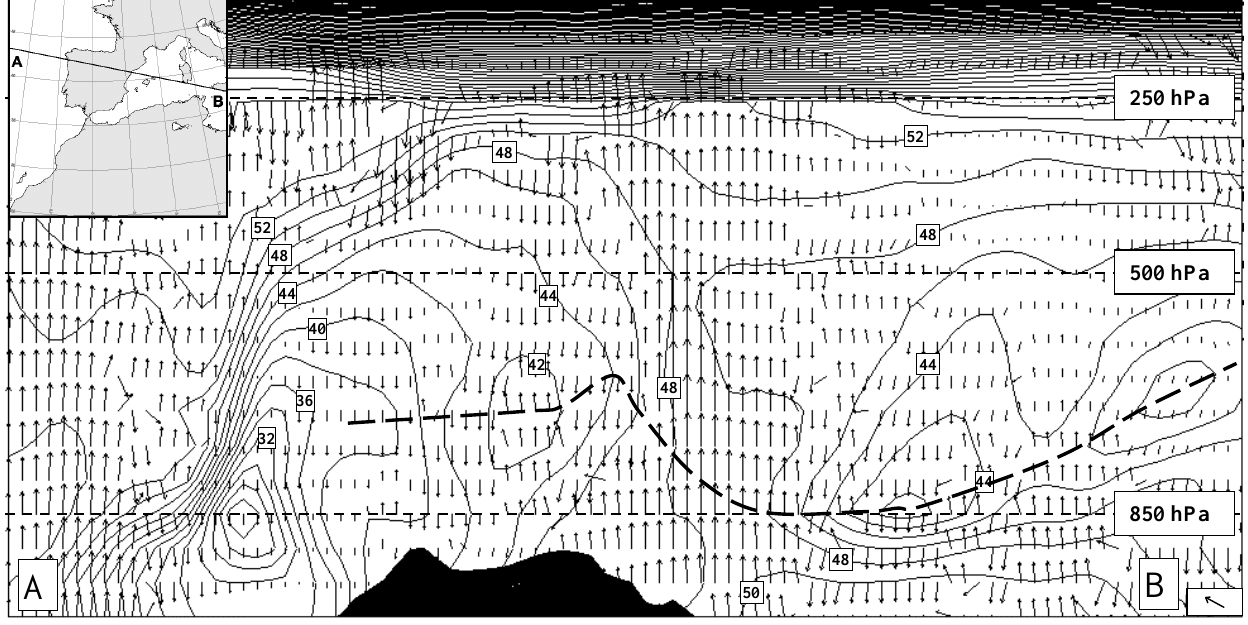
Fig. 10. Vertical cross section of domain 2 showing equivalent potential temperature ( ◦ C) and wind (m/s) on 12:00UTC, 22 October 2000. Strong dashed line bounds the region with greater convective instability. The top left map shows the vertical section position. The wind scale is indicated by the bottom right corner vector with components 13m/s in the horizontal and 0.07m/s in the